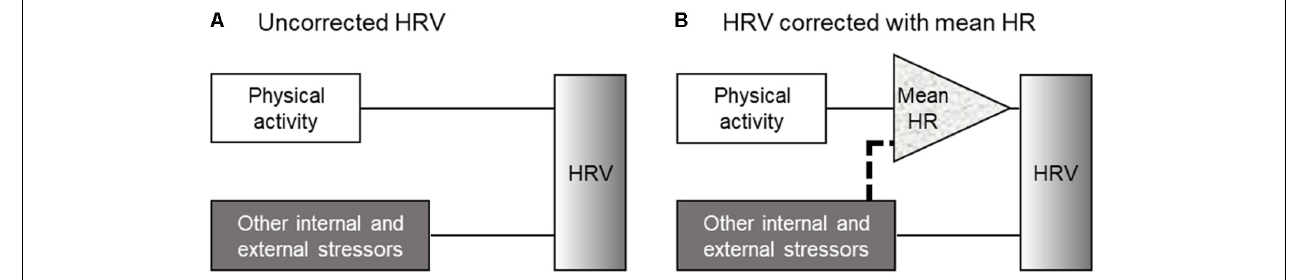
FIGURE 5 | Schematic views of the analytical methods used to correct the effect of physical activity on HRV in the present study. (A) The inclusion of DBA as a covariate into uncorrected HRV analysis and (B) the inclusion of DBA as a covariate into the HR-corrected HRV analysis. When the correlation between physical activity and mean HR is extremely high, the method shown in (A) and the method used to correct HRV for the mean HR yielded similar results. On the other hand, when the stressors other than physical activity affect mean HR per se , the method shown in (B) could reveal the nonlinear relationship between physical activity and mean HR ( dotted line in B ). DBA, dynamic body acceleration; HR, heart rate; and HRV, heart rate